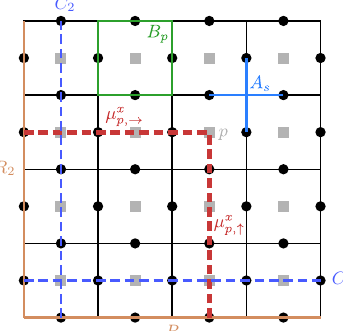
Figure 10: Toric Code on a torus. Black dots show the positions of the Toric Code variables σ x , z , grey squares the dual lattice for the variables µ x , z . C depict an p 1,2 i (arbitrary) choice of the two incontractible loops winding around the torus, which define the Wilson loop operators t . The reference lines R are used to define the 1,2 1,2 reference positions for the operators µ x . See text for further p , → ( ↑ )